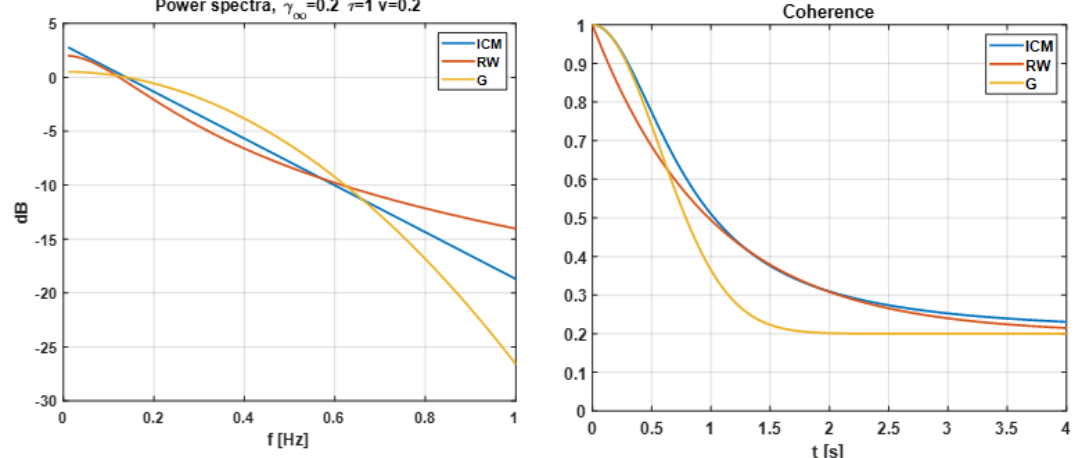
Figure 3. PSD ( left ) and autocorrelation ( right ) of the three models assumed: the Intrinsic Clutter Model (ICM), the generalized Random Walk (gRW), and the Gaussian one, plotted by imposing the fitting here